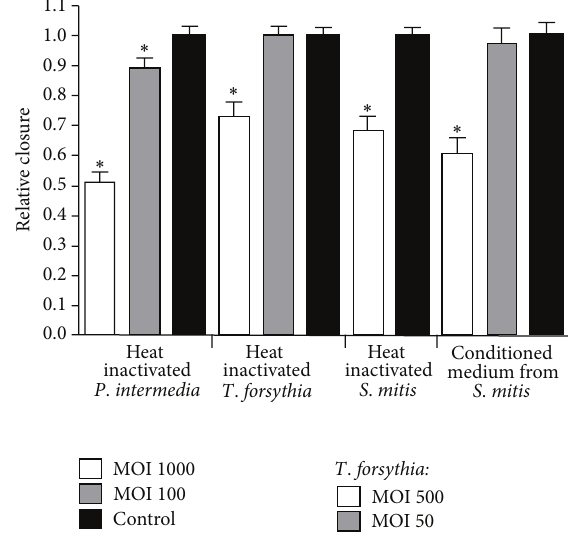
Figure 4: Relative closure (mean + SEM) of scratch in oral epithelial cells challenged with different numbers of heat inactivated P. intermedia , T. forsythia , S. mitis , and conditioned medium from S. mitis . Relative closure significantly different ( 𝑃 < 0.05 ) from control is marked with ∗